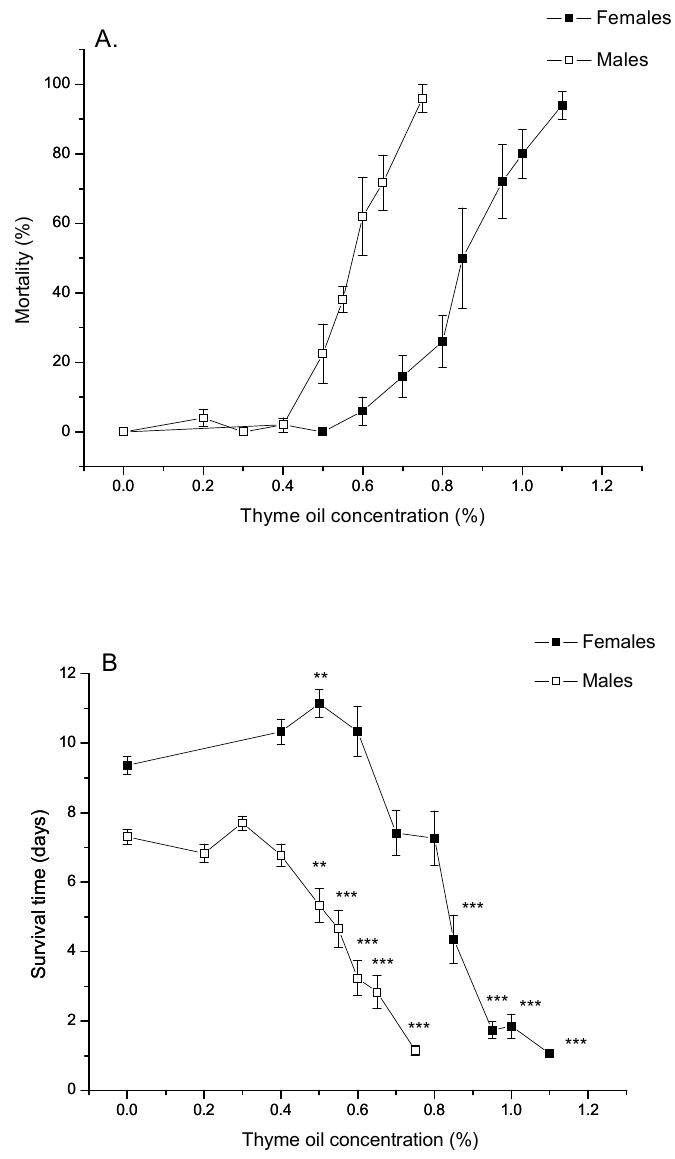
Figure 1. ( A ) Percentage of mortality after 24 h of exposure to thyme oil (means and standard errors for 5 replicates) and ( B ) survival time in Acanthoscelides obtectus females and males (means and standard errors for beetles that survived the 24 h essential oil (EO) treatment). Significant differences between control and EO-treated groups within each sex are presented with asterisks (** p < 0.01, *** p < 0.001).